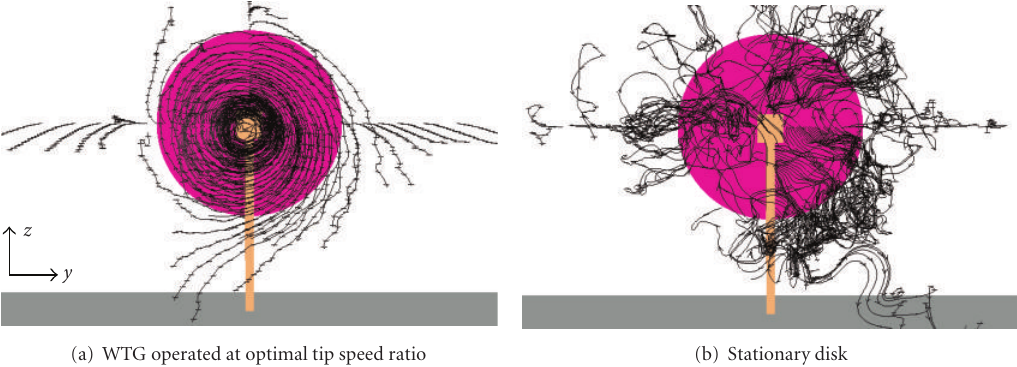
Figure 9: Flow visualization of the vortex structure of the wake flow. Rear view showing streamlines for the instantaneous field.